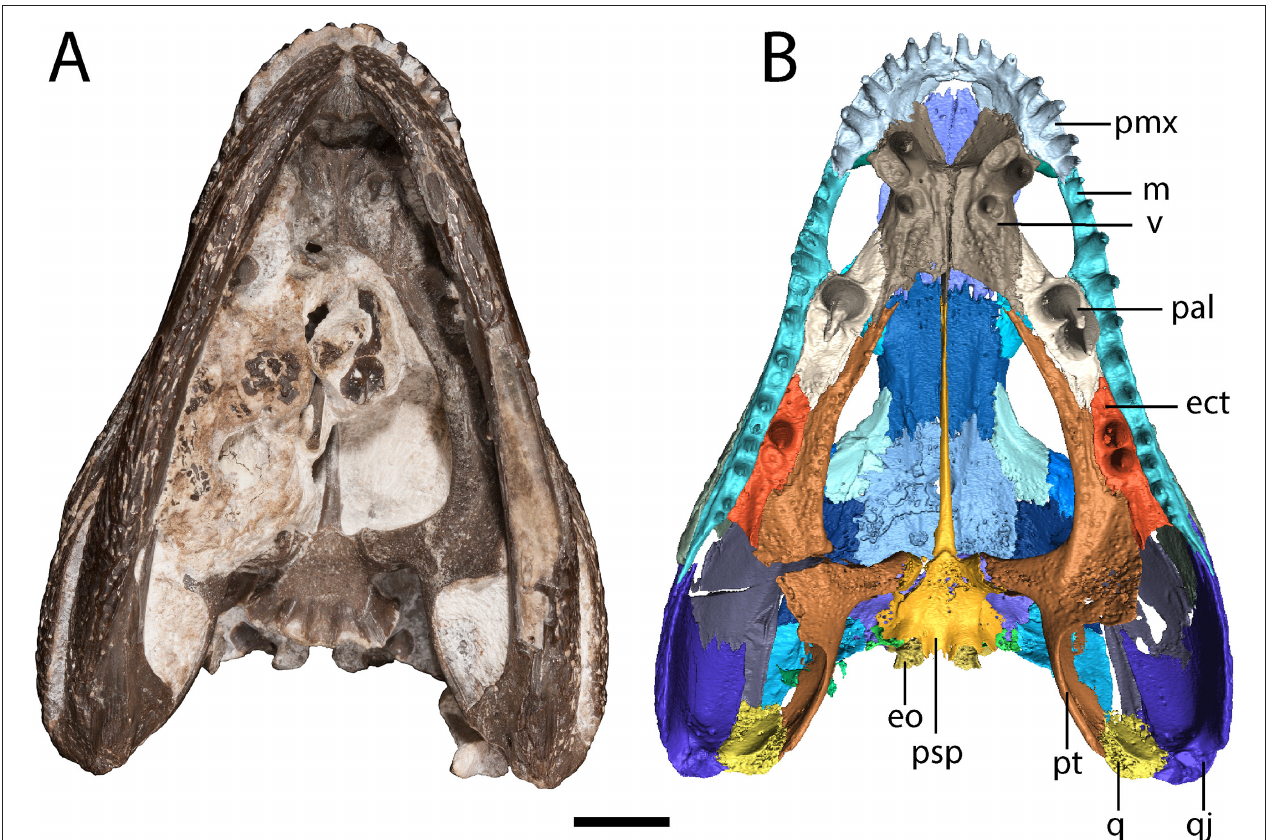
FIGURE 3 | OMNH 79318, cf. Acheloma , entire specimen in ventral profile. (A) photograph; (B) digitally segmented rendering of the skull roof and palate; Scale bar equal to